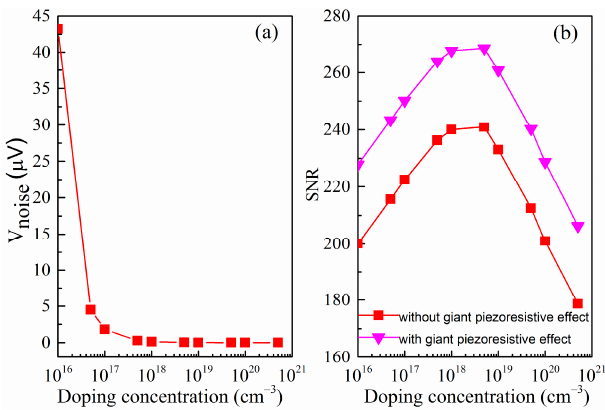
Figure 7. ( a ) Variation of the voltage noise with doping concentration of the SiNW piezoresistor; and ( b ) variation of SNR with doping concentration of the SiNW piezoresistor.